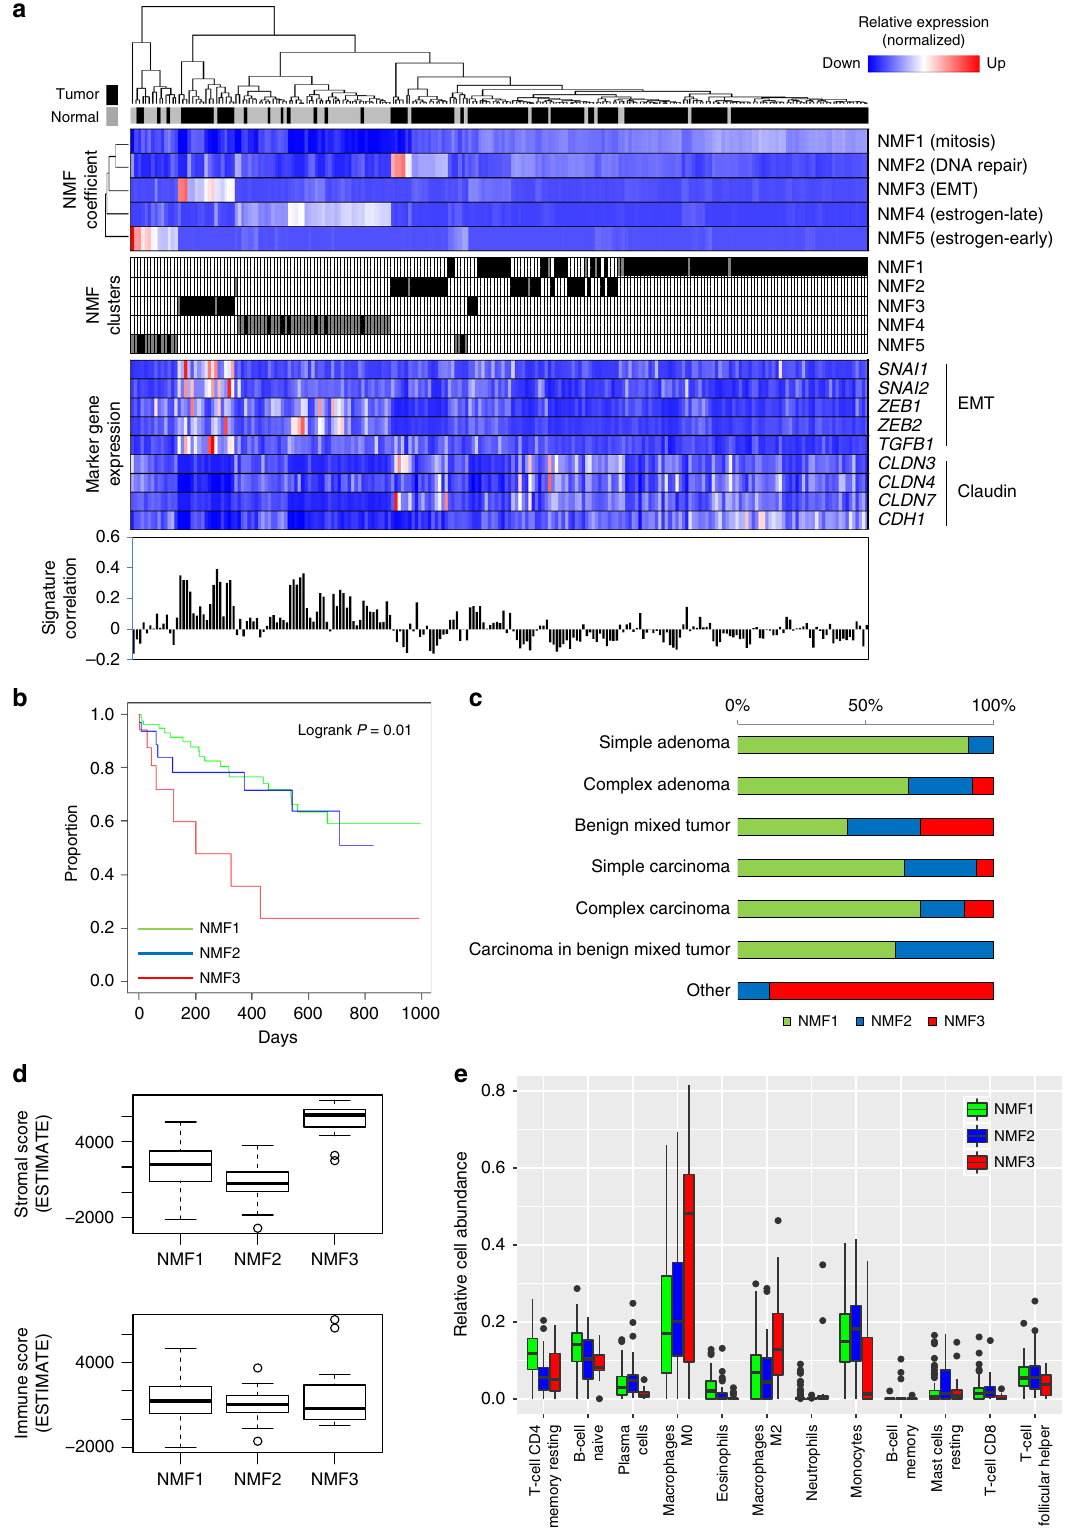
enrichment plots and top-enriched genes (i.e., leading edge genes) for the selected functions of the fi ve metagene signatures are shown in Supplementary Fig. 6. Marker gene expression analysis revealed that NMF3 CMTs showed upregulation of the EMT markers SNAI1/2 , ZEB1/2 , and TGFB1 . Of note, NMF3 CMTs further showed down-regulation of claudin-encoding genes